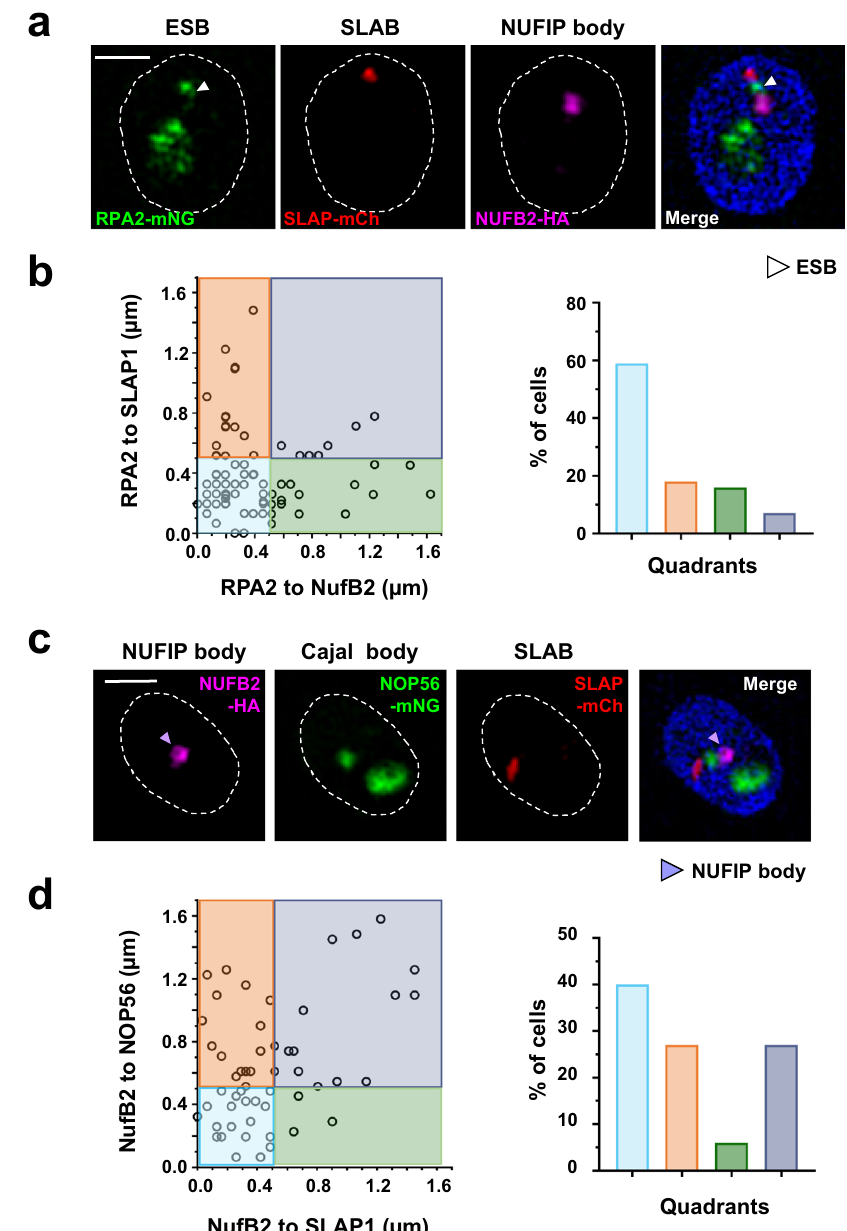
Fig. 7 An assembly of nuclear bodies associates with the active ES in BF T. brucei . a Simultaneous visualisation of the ESB, SLAB and NUFIP bodies using SR-SIM imaging of a triple epitope-tagged BF T. brucei cell line. This cell line expresses mNG::RPA2 (RPA2-mNG, green), mCh::SLAP1 (SLAP-mCh, red) and NufB2::6HA (NufB2-HA, magenta). The ESB is indicated with a white arrowhead within a nucleus (dashed line) stained with DAPI (blue). Scale bar = 1 μ m. b Quantitation of the distance between the ESB (visualised with RPA2) and the SLAB (visualised with SLAP1) compared with the distance between the ESB and the NUFIP body (visualised with NufB2). Data was of the cell line shown in ( a ) using SR-SIM imaging. The scatter plot is divided into four quadrants which are coloured according to whether the different bodies in the cells are within 500 nm of each other. Quantitation of the percentage (%) of cells within each coloured quadrant is on the right. Example images of cells from each quadrant are shown in Supplemental Fig. 10. N = 110 cells in G1 (1K1N) from two biological replicates. c Simultaneous visualisation of the Cajal, SLAB and NUFIP bodies using SR-SIM imaging of a triple epitope-tagged cell line. This line expresses mNG::NOP56 (NOP56-mNG, green), mCh::SLAP1 (SLAP-mCh, red) and NufB2::6HA (NufB2-HA, magenta). The NUFIP body is indicated with a light-purple arrowhead within a nucleus (dashed line) stained with DAPI (blue). Scale bar = 1 μ m. d Quantitation of the distance of the Cajal body (CB) (visualised with NOP56) and the NUFIP body (visualised with NufB2) compared with the distance between the SLAB (visualised with SLAP1) and the Cajal body. Data were from the cell line shown in ( c ) using SR-SIM imaging. The scatter plot is divided into quadrants, which are coloured differently according to whether the different bodies in the cells are within 500 nm of each other. Example images of cells from each quadrant are shown in Supplemental Fig. 10. N = 55 cells in G1 (1K1N) from two biological replicates. Source data are provided as a Source Data fi